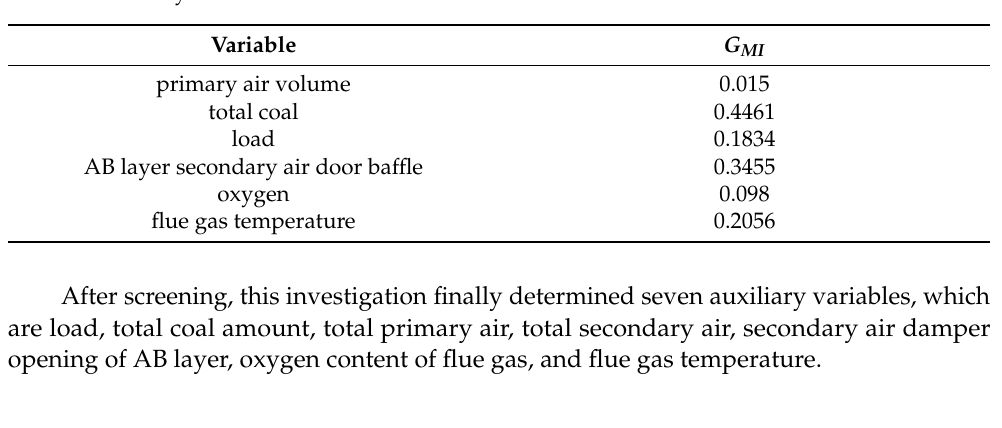
Table 2. Auxiliary variable evaluation function